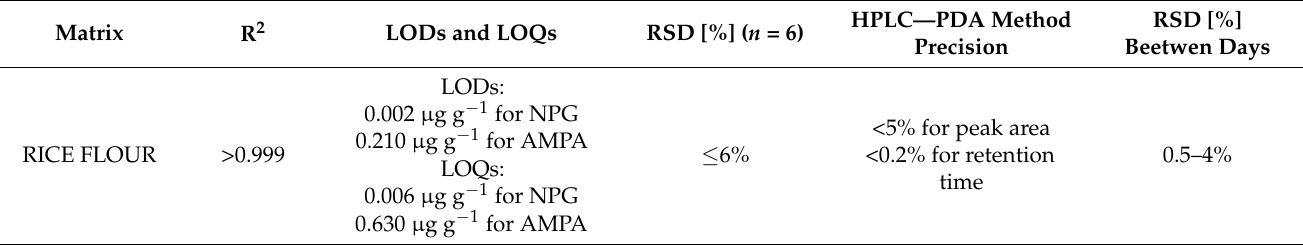
Table 3. Results obtained in the validation experiments.